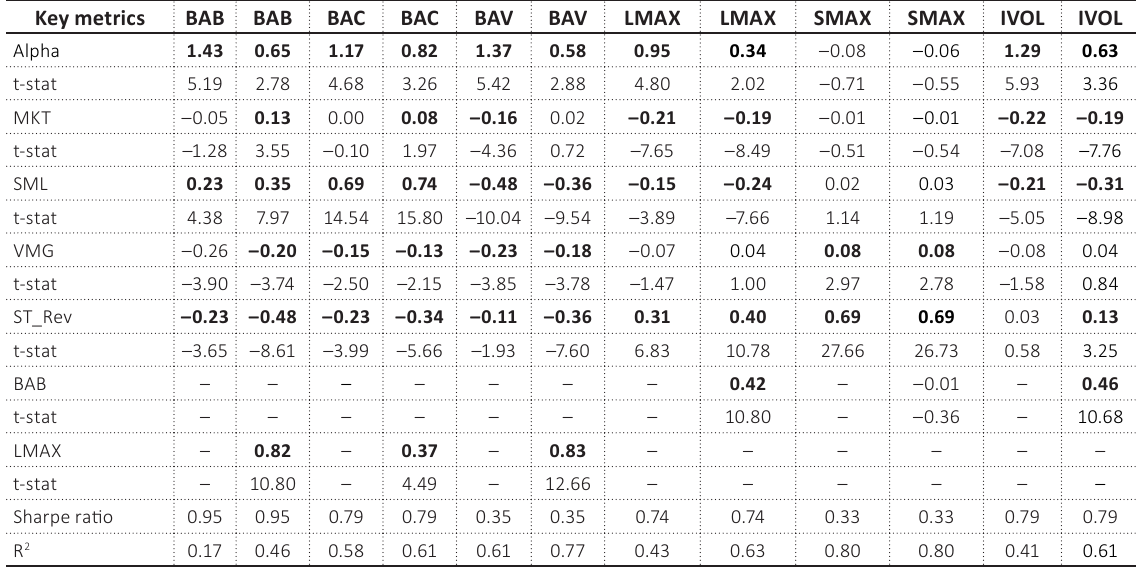
Table C1. Performance marathon among factors constructed using the rank-weighted method